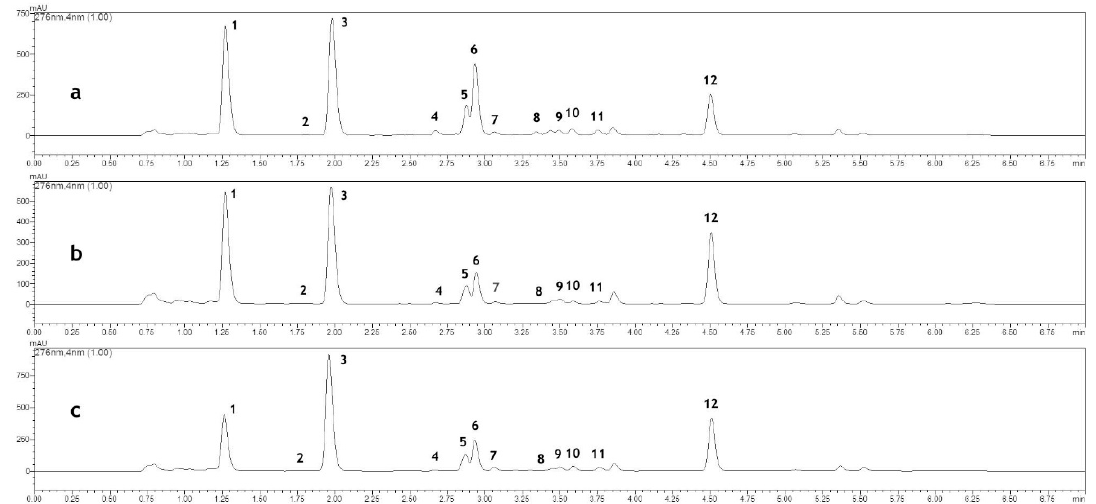
Figure 1. High-performance liquid chromatography (HPLC) chromatogram (monitored at 276 nm) of herb extracts obtained from plants grown: ( a ) in full sunlight; ( b ) in 30% shade; ( c ) in 50% shade. The following compounds were analyzed: ( 1 ) chlorogenic acid; ( 2 ) ca ff eic acid; ( 3 ) o -coumaric acid 2- O -glucoside; ( 4 ) p -coumaric acid; ( 5 ) verbascoside; ( 6 ) luteolin 7- O -glucoside; ( 7 ) ferulic acid; ( 8 ) 3,4-dihydroxycoumarin; ( 9 ) cichoric acid; ( 10 ) apiin; ( 11 ) o -coumaric acid; ( 12 ) coumarin. Table 1. Effects of plant shading on the content of phenolic compounds in the herb (mg 100 g − 1 dry weight (DW) ). Shade Level Developmental Compounds Stage 0% 30% 50%